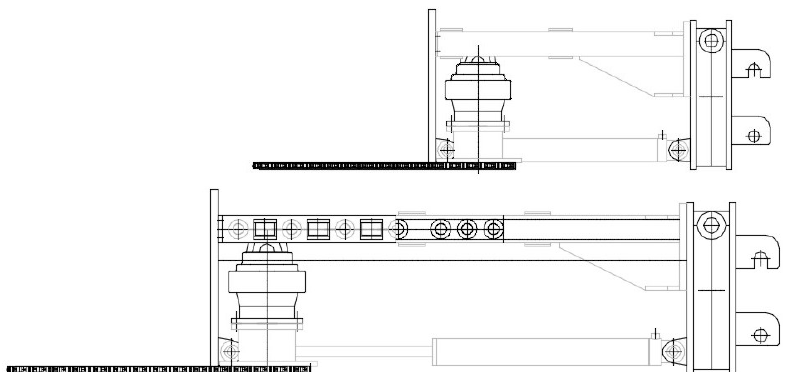
Figure 6. CAD drawings of the prototype mining adapter.